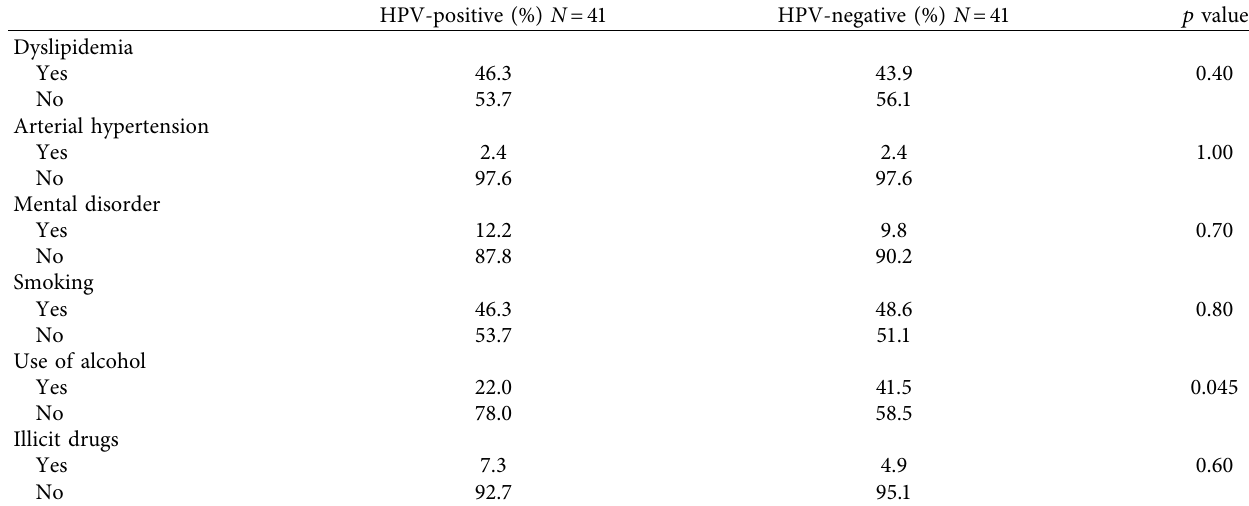
Table 2: Comorbidities in HIV-positive women with and without HPV coinfection, São Lu´ıs, Maranhão, Brazil, 2018–2019.